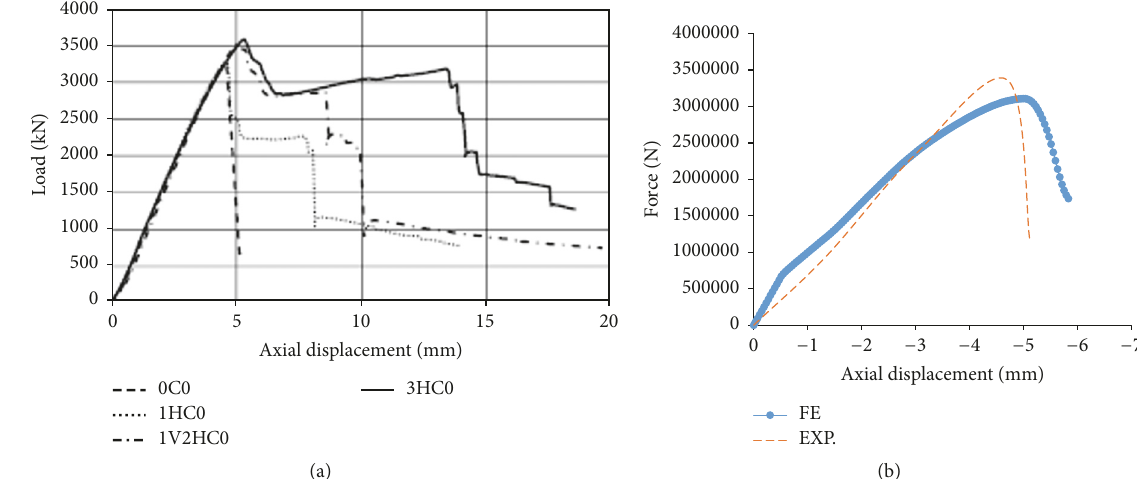
Figure 12: Result of finite element analysis (b) and experimental results [17]